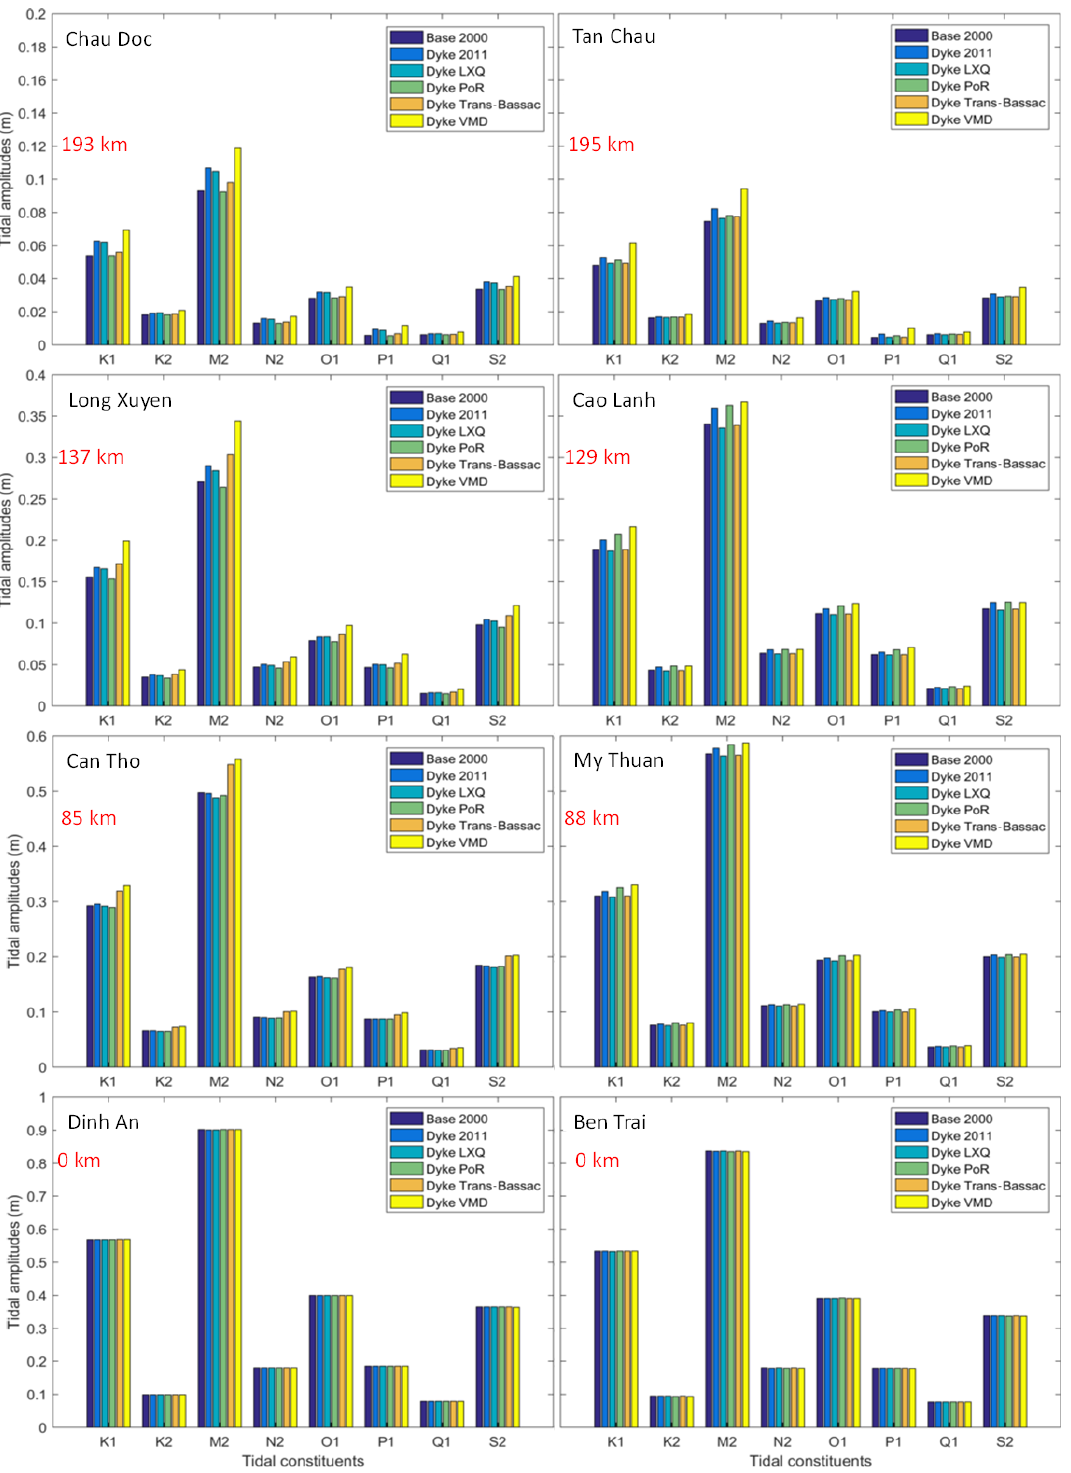
Figure 11. Tidal amplitudes of the eight main constituents at the selected stations along the Tien River (right) and Hau River (left) from the river mouths to about 195km landward in the high-dyke development